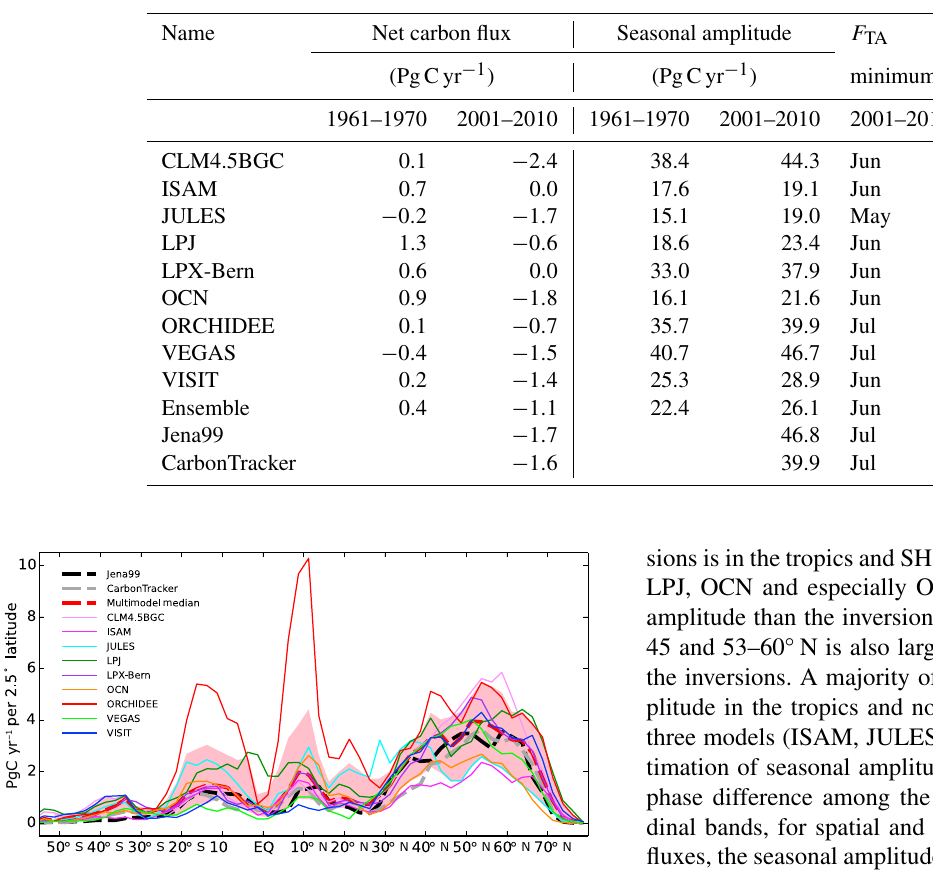
Figure 3. Latitudinal dependence of the seasonal amplitude of land–atmosphere carbon flux from the TRENDY multimodel me- dian (red line, and the pink shading indicates the 10 to 90 per- centile range of model spread), two atmospheric CO 2 inversions, Jena99 (black dashed line) and CarbonTracker (gray dashed line), and each individual model (thin line). Fluxes are first resampled to 2.5 ◦ × 2.5 ◦ , then summed over each 2.5 ◦ latitude band (PgCyr − 1 per 2.5 ◦ latitude) for the TRENDY ensemble and